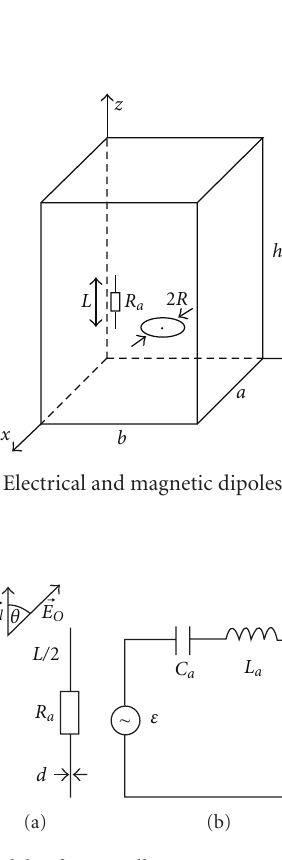
Figure 2: Model of a small near-resonance electrical dipole